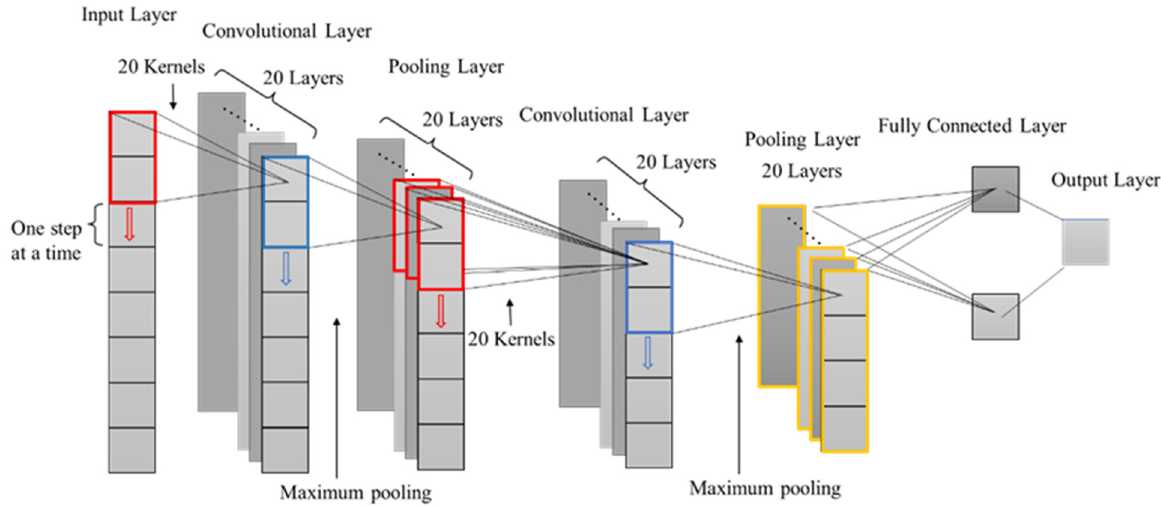
Figure 3. The flowchart of fault identification by CNN. 3. Fault Identification Example Taking a mining area in the east of Yunnan province as an example, seismic data are processed and interpreted by Geoframe software, and the distribution of man-made faults in the mining area is obtained. As shown in Table 1, the mining area attribute data are comprised of eight attributes collected from the seismic data in the mining area. The min- ing area is depicted in Figure 4, with a total of 159,466 sample points, of which 5800 are known, distributed in the four regions of ABCD. Table 2 summarizes the number and proportion of fault and non-fault points in each region. Table 2. Statistical table of faults in each region . Regions